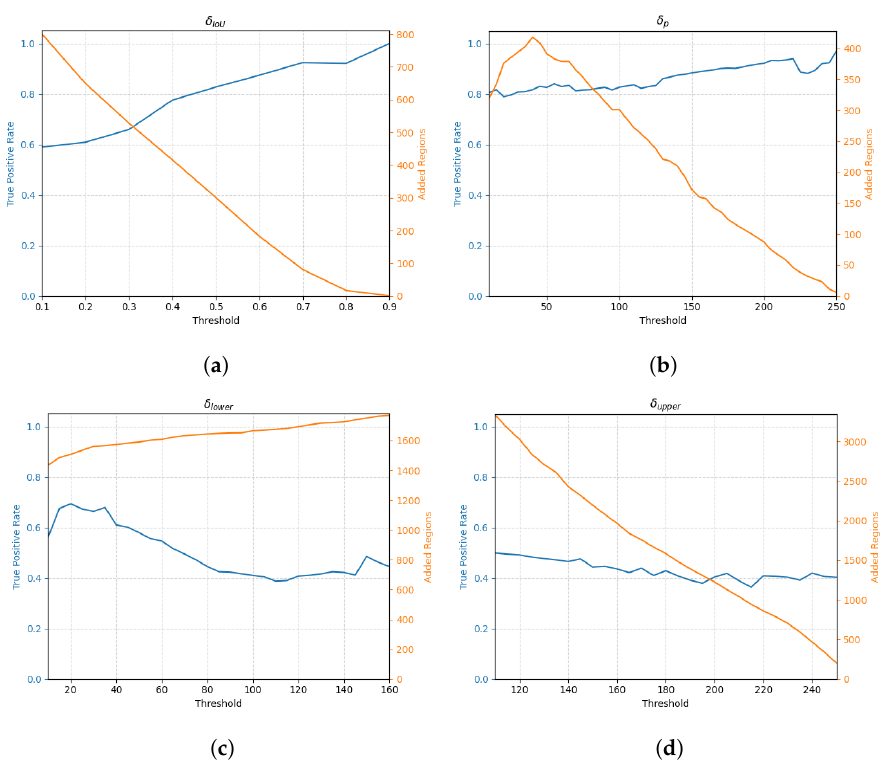
Figure 7. Illustrations of the effect of different parameters for the label revision function. In each plot, the blue curve shows the TPR of pixels added to the labels and the orange curve shows how many regions were added. The top row shows the parameters of the MAL experiment and the bottom row shows the parameters of the self-training experiment. ( a ) illustrates the effect of the choice of δ IoU , ( b ) of δ p , ( c ) of δ lower and ( d ) of δ upper